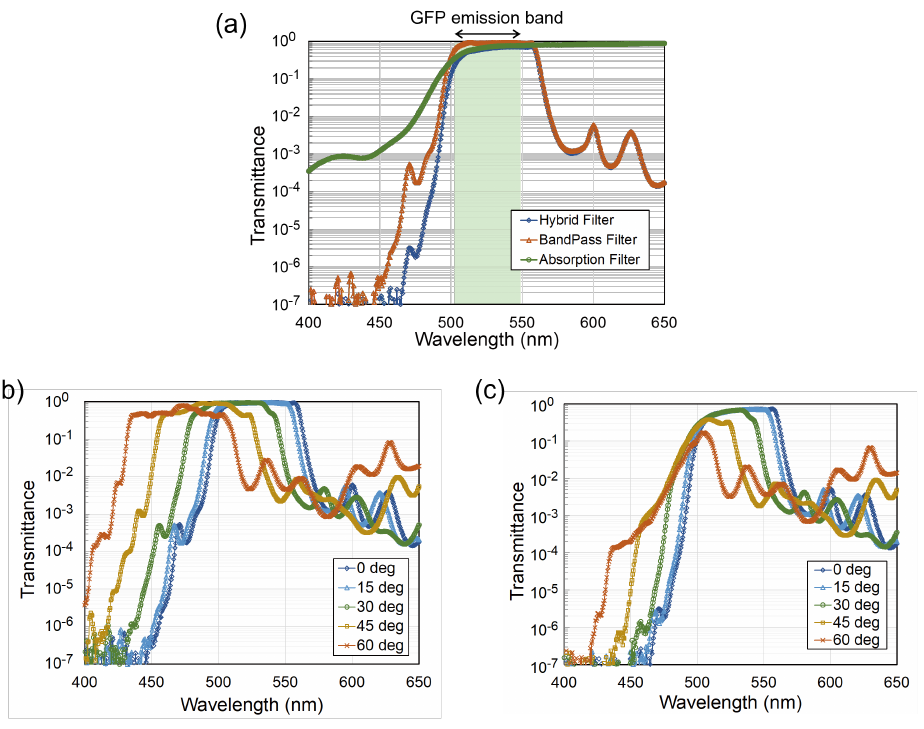
Figure 4. ( a ) Filter transmission spectra compared with the green fluorescence protein (GFP) emission on a logarithmic scale. ( b ) Transmission spectra of the interference filter with the various angles of incidence. ( c ) Transmission spectra of the hybrid filter with the various angles of